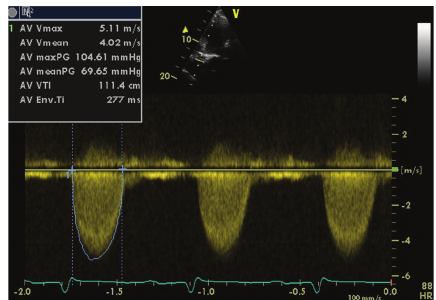
Figure 1: Echocardiography, continuous-wave spectral Doppler across the aortic valve showed severe aortic stenosis with mean gradient 70 mmHg and peak gradient 105mmHg.